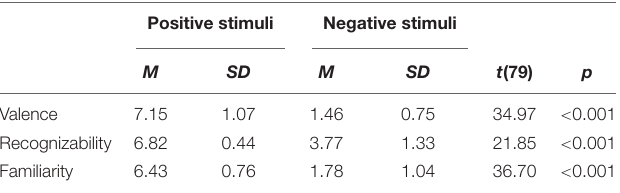
TABLE 3 | Valence, recognizability, and familiarity ratings of positive and negative prime stimuli in Study 3. Positive